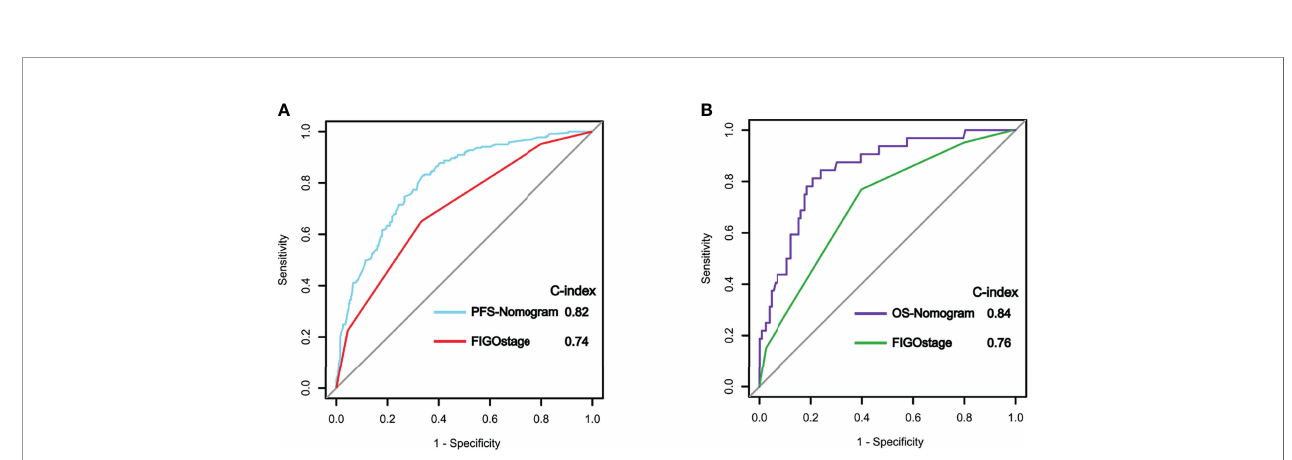
FIGURE 5 | Receiver operating characteristic (ROC) curve analysis of progression-free survival (PFS) (A) and overall survival (OS) (B) in the training cohort using the nomograms and the FIGO staging system.